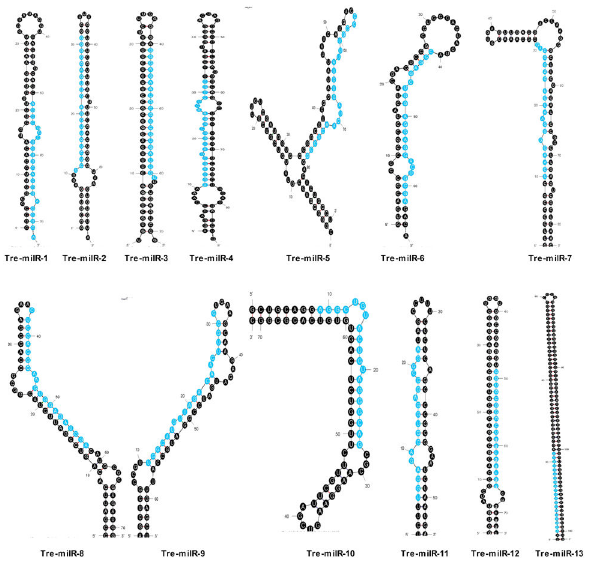
Figure 3. Prediction of T. reesei pre-milRNAs hairpin